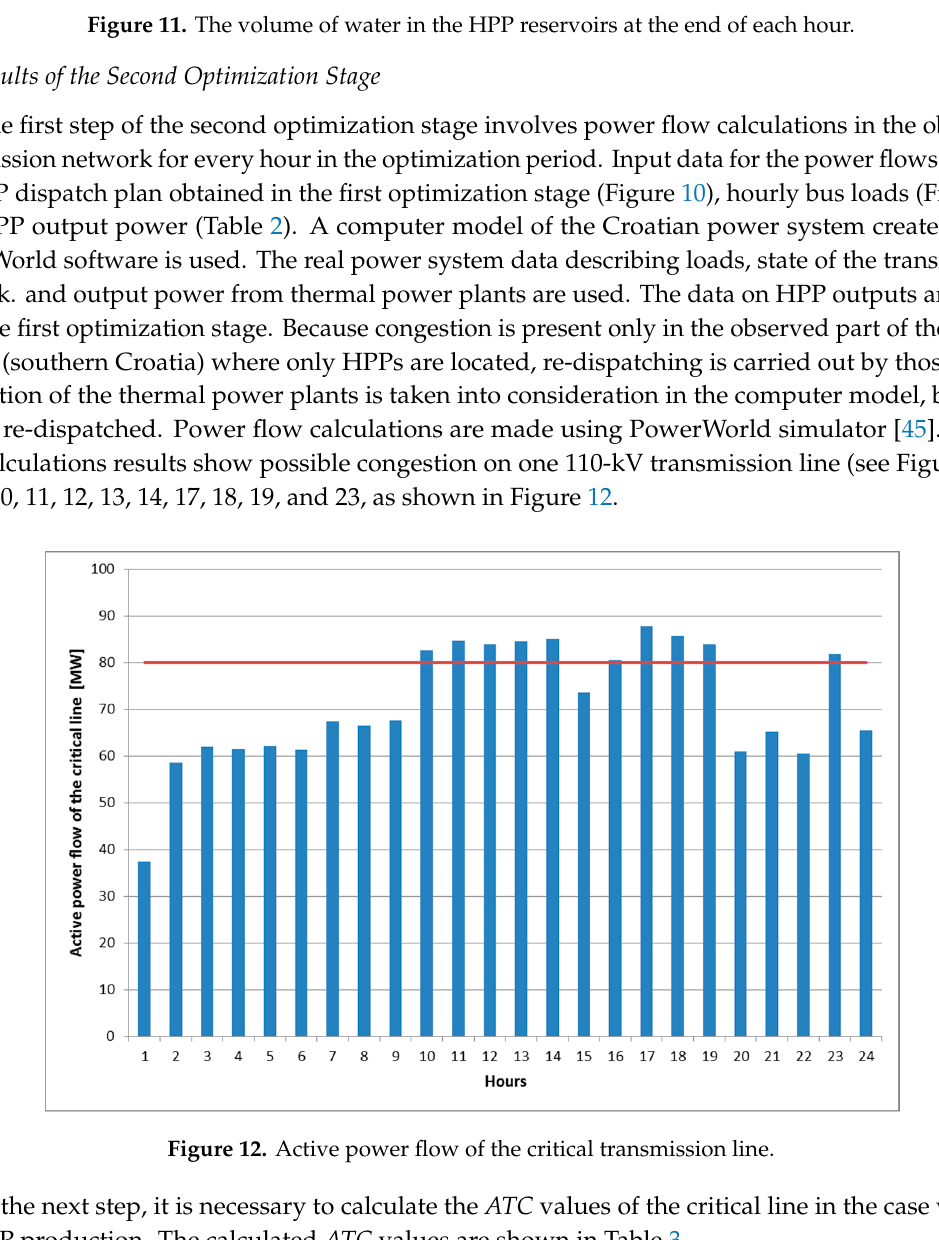
Table 3. Calculated available transfer capacity (ATC) values for the critical line.